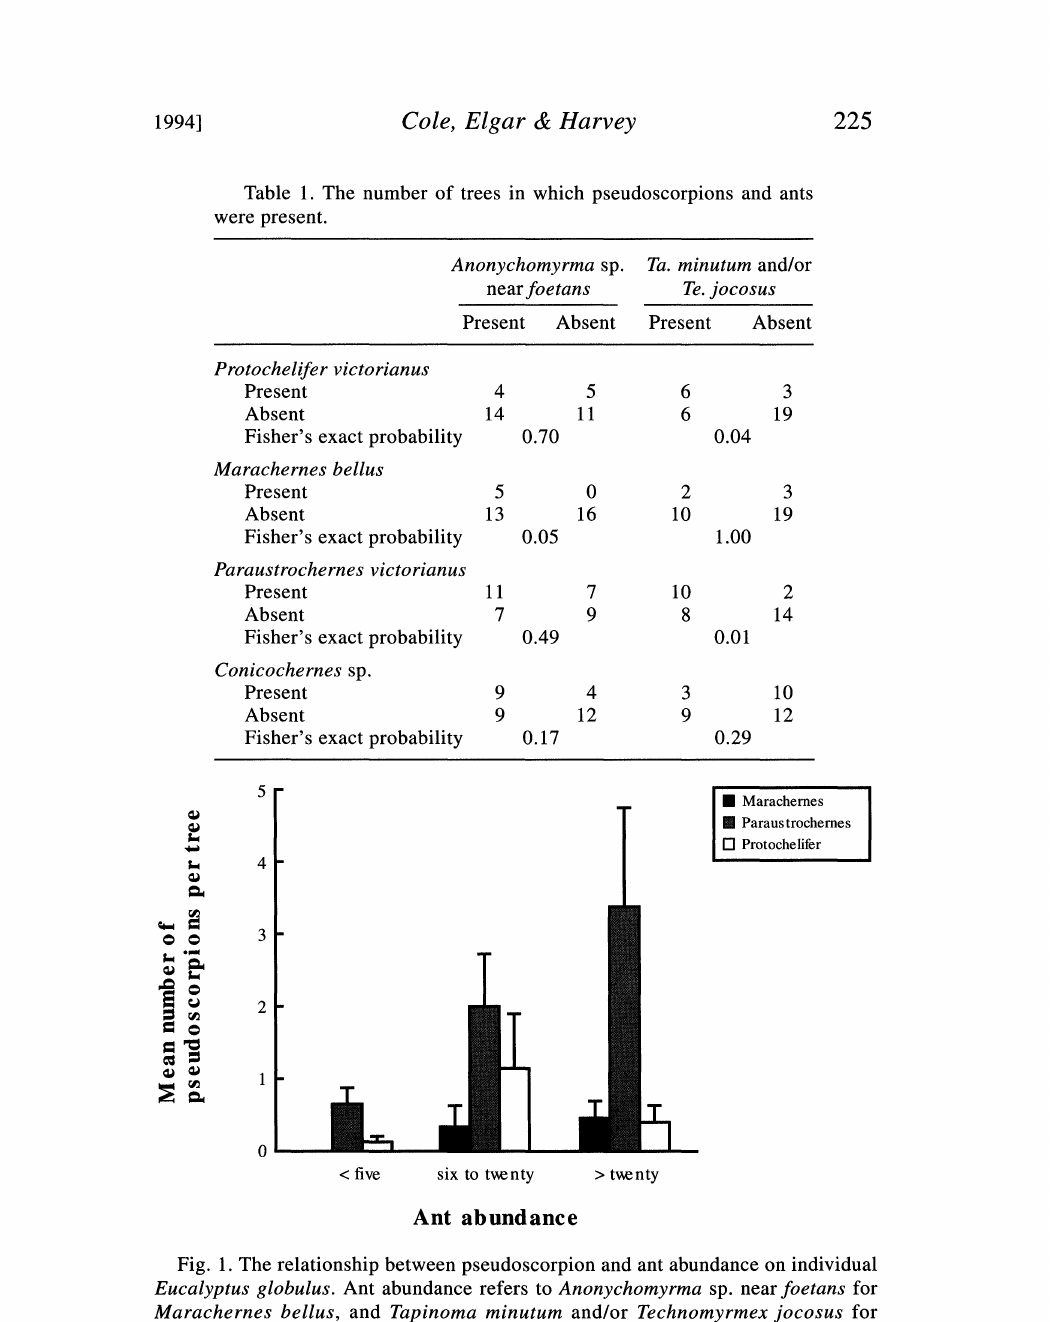
Table 1. The number of trees in which pseudoscorpions and ants were present.